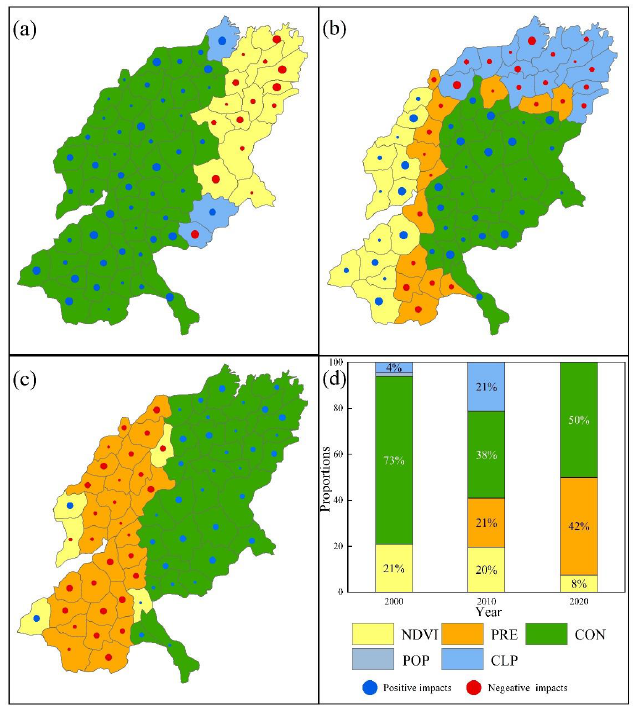
Figure 14. ESs’ trade-off drivers in different cities of WY_HQ (( a ) in 2000; ( b ) in 2010; ( c ) in 2020). ( d ) Proportion of area accounted for by key ES trade-off drivers in different years (Refer to Tables 2 and 3 for the meanings of each symbol).